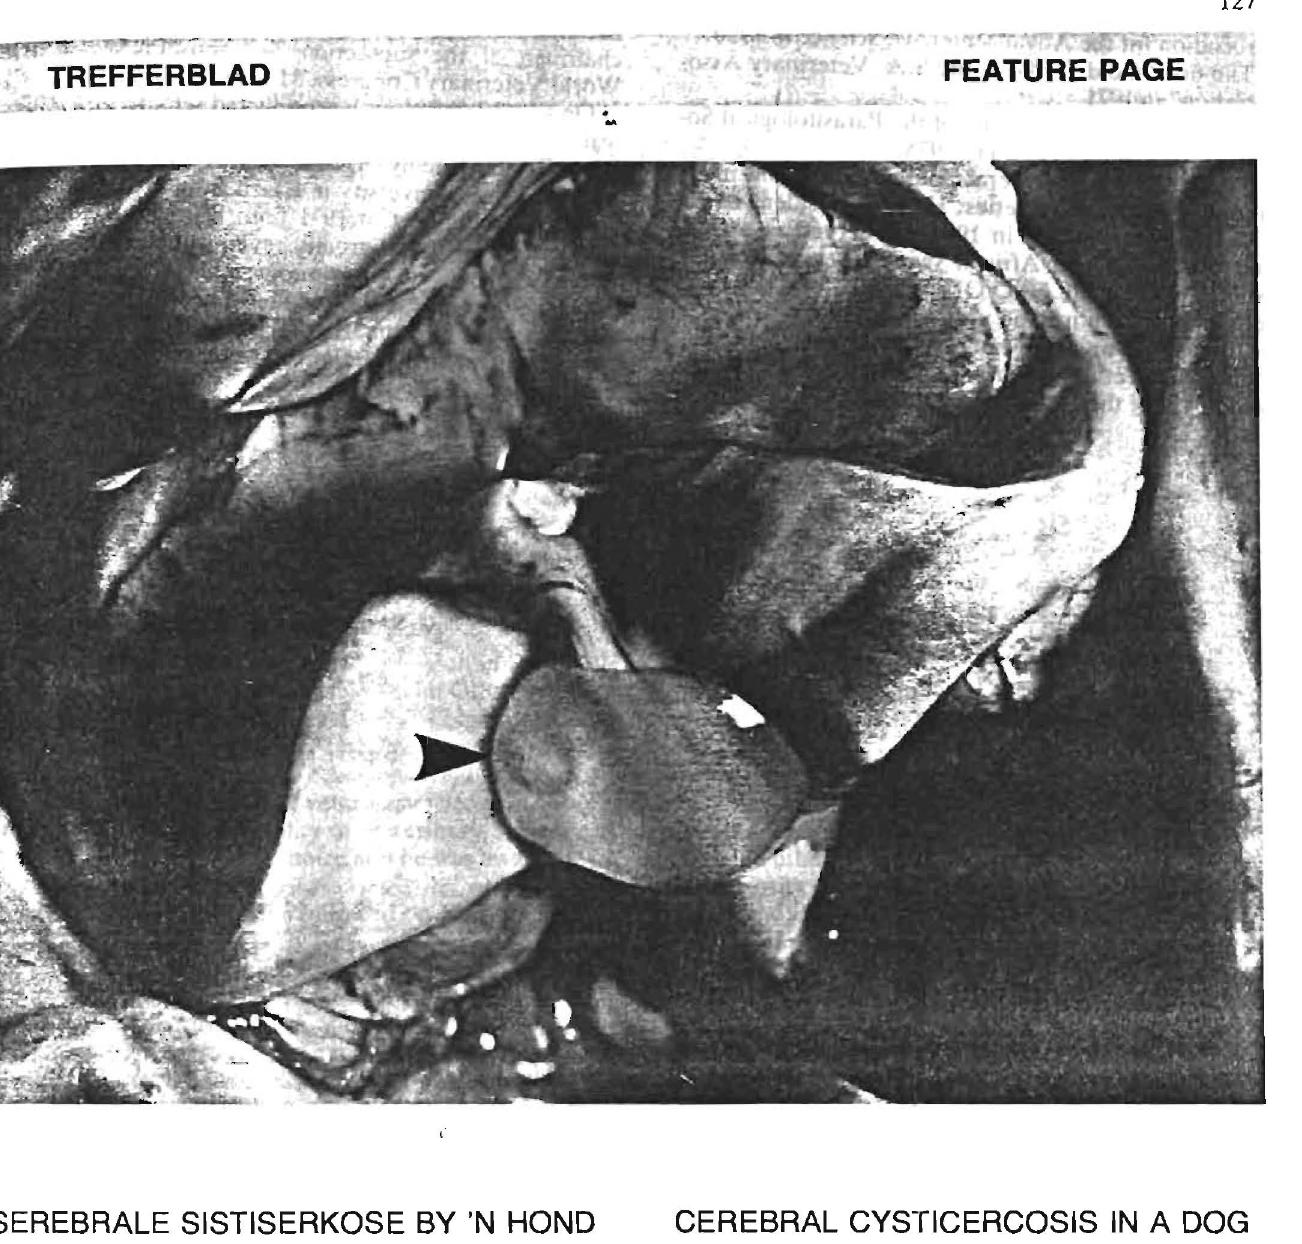
The Cysticercus cellulosae (indicated by an arrow)